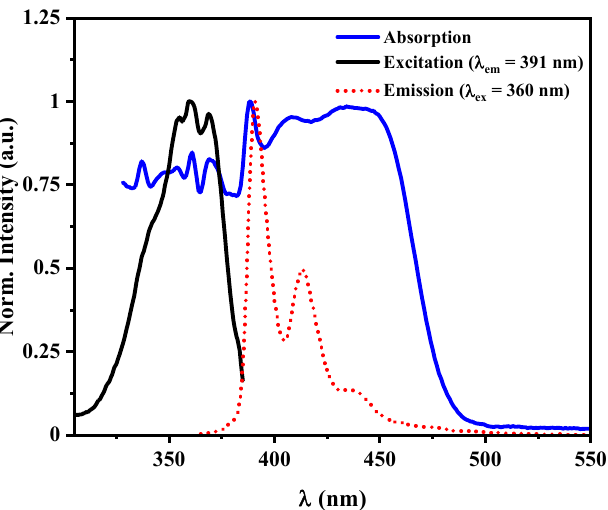
Figure 5. Comparison of normalized absorption, excitation, and emission spectra of 7 in chloroform, C = 5 × 10 − 6 M.